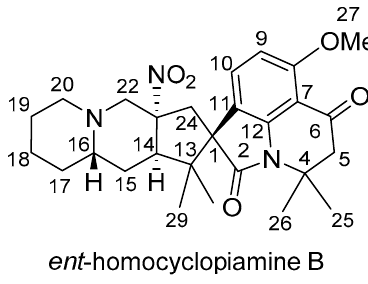
Figure 2. Structure of compound 1.